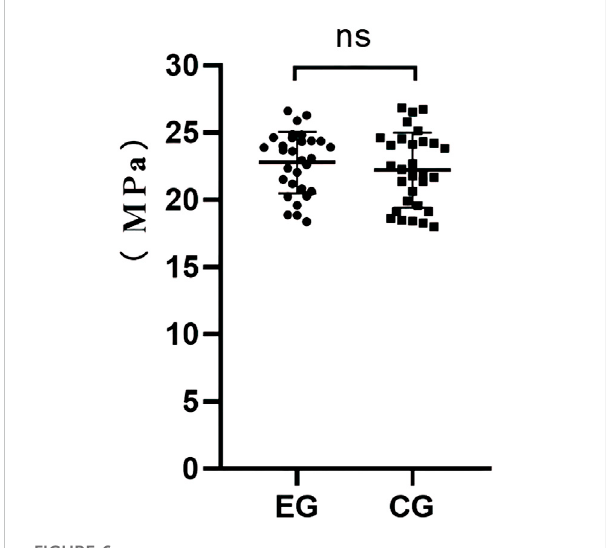
FIGURE 6 SBS distribution of experimental group (EG) and conditional control group